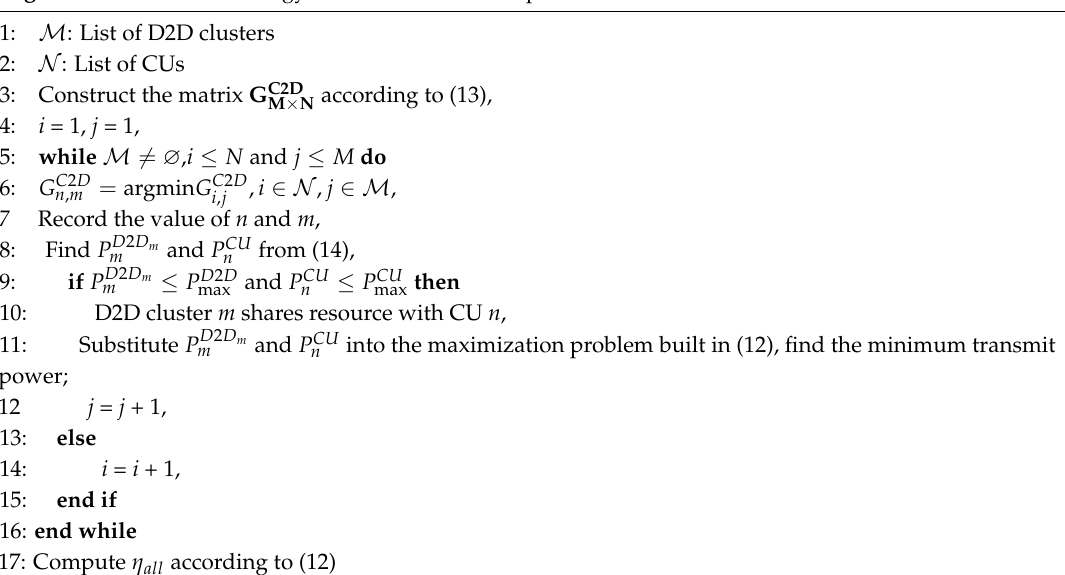
Algorithm 1 A heuristic energy-efficient resource and power allocation scheme for D2D multicast